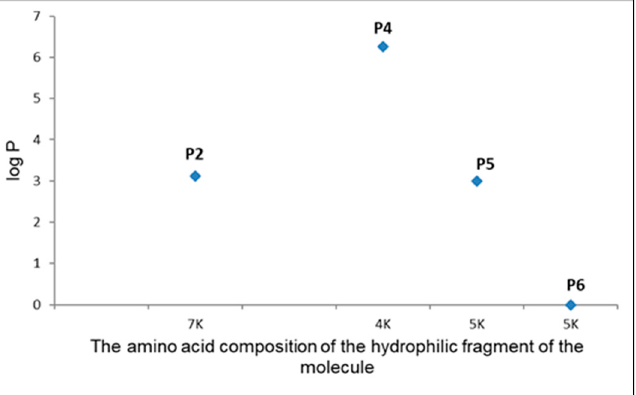
Figure 11. Chart of the dependence of the amino acid composition of the polar fragment of the molecule on the log P. Marking on the axis of arguments mean K-lysine.